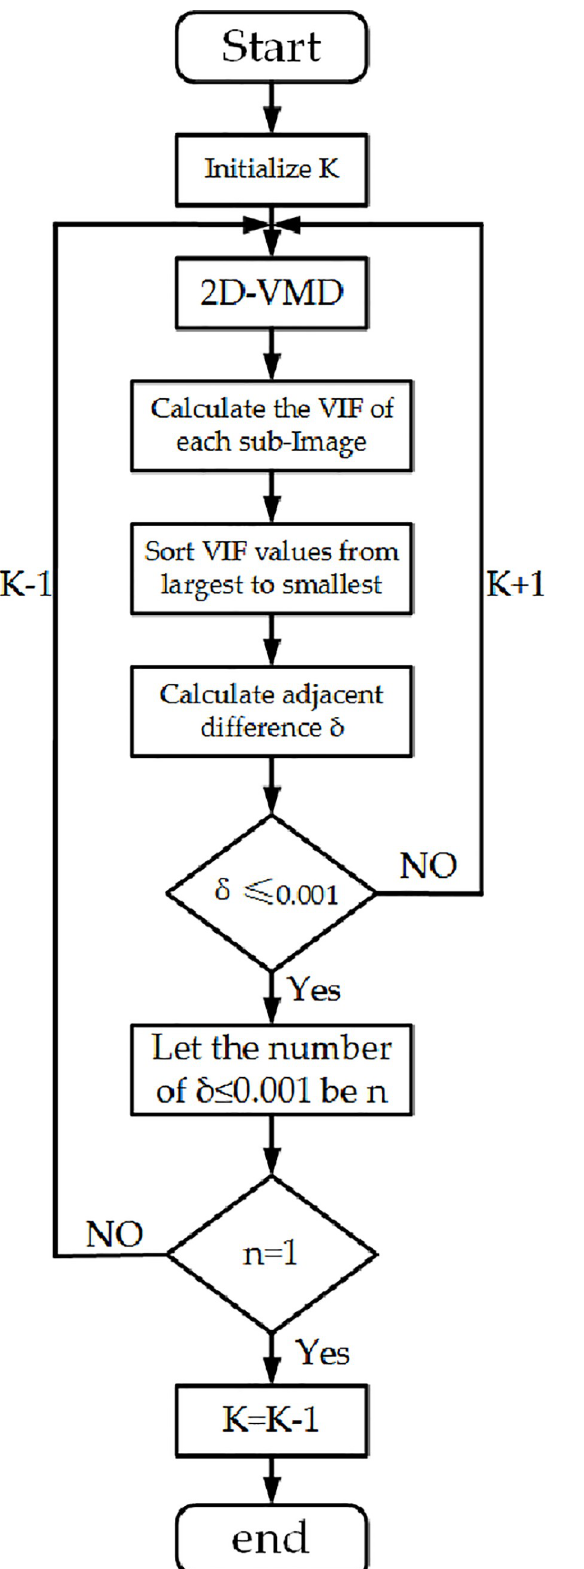
Fig 3. Flow chart of selecting K